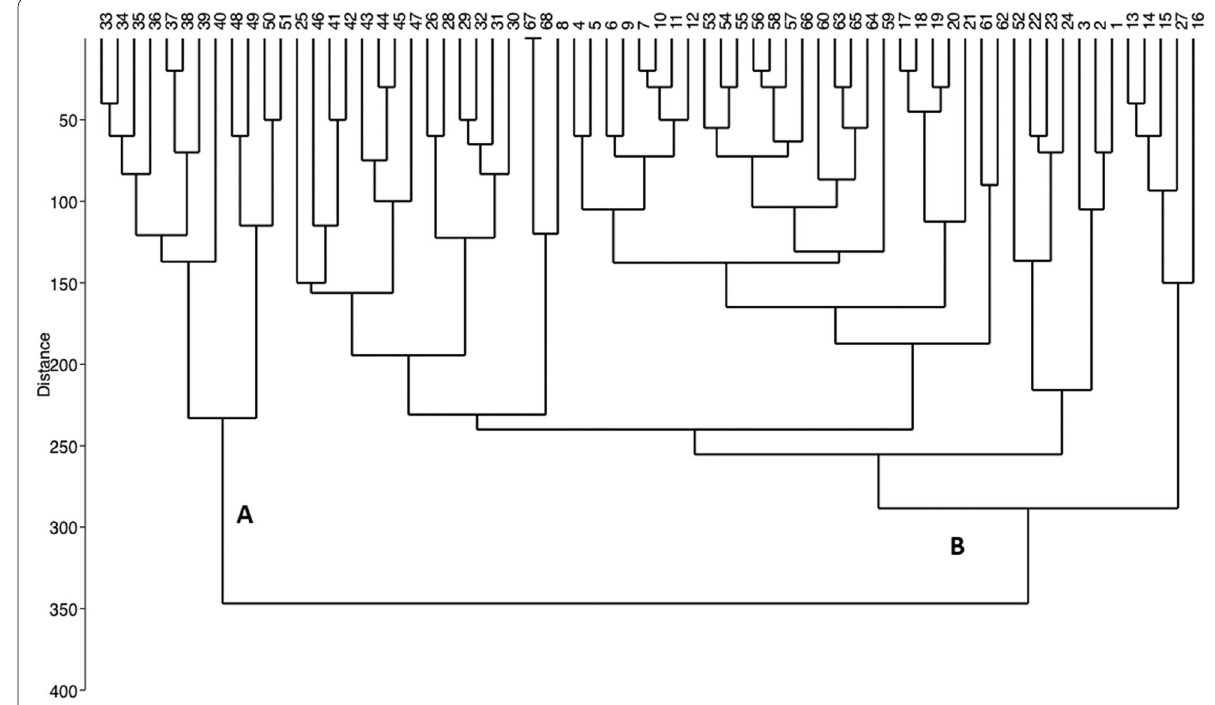
Fig. 2 WARD grouping method based on SSR data, cultivars are divided into two main groups: A and B. Number of individuals are according to Table